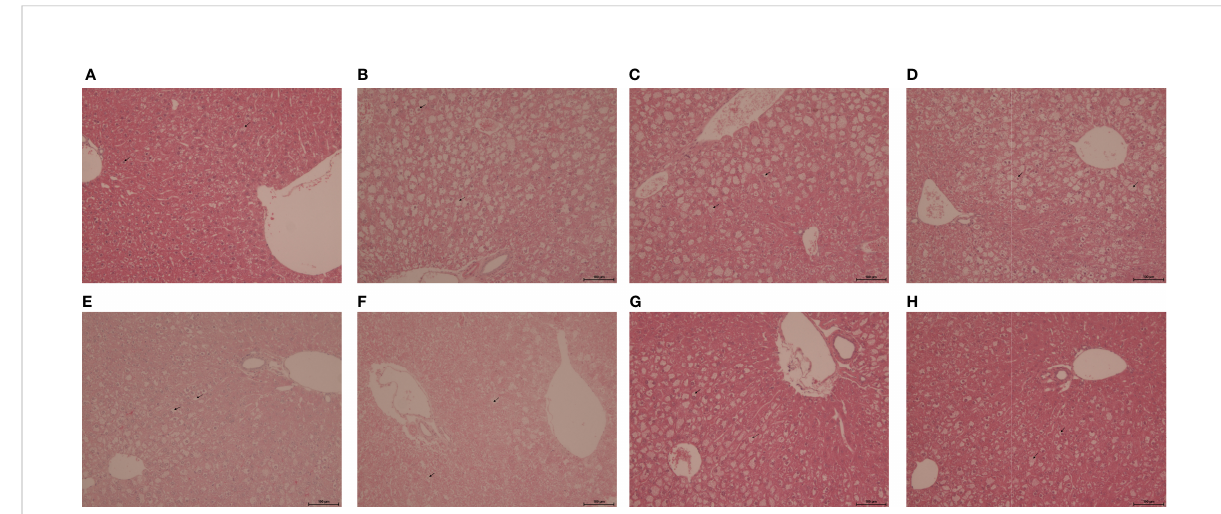
FIGURE 3 Representative H&E-stained liver sections from 11-week-old lean db + and obese db/db mice treated with (A) db + control, (B) db/db control, (C) GRT (100 mg/kg BW), (D) Glyb (5 mg/kg BW), (E) Ator (80 mg/kg BW), (F) GRT with Glyb, (G) GRT with Ator, and (H) GRT with Glyb, and Ator, respectively, for 5 weeks. N = 5-6/group. Microvesicular steatosis represented by a bold arrow and mediovesicular steatosis by a dotted line arrow. Magni fi cation x 200; scale bar 100 m m. GRT, green rooibos extract; Glyb, glyburide; and Ator, atorvastatin.